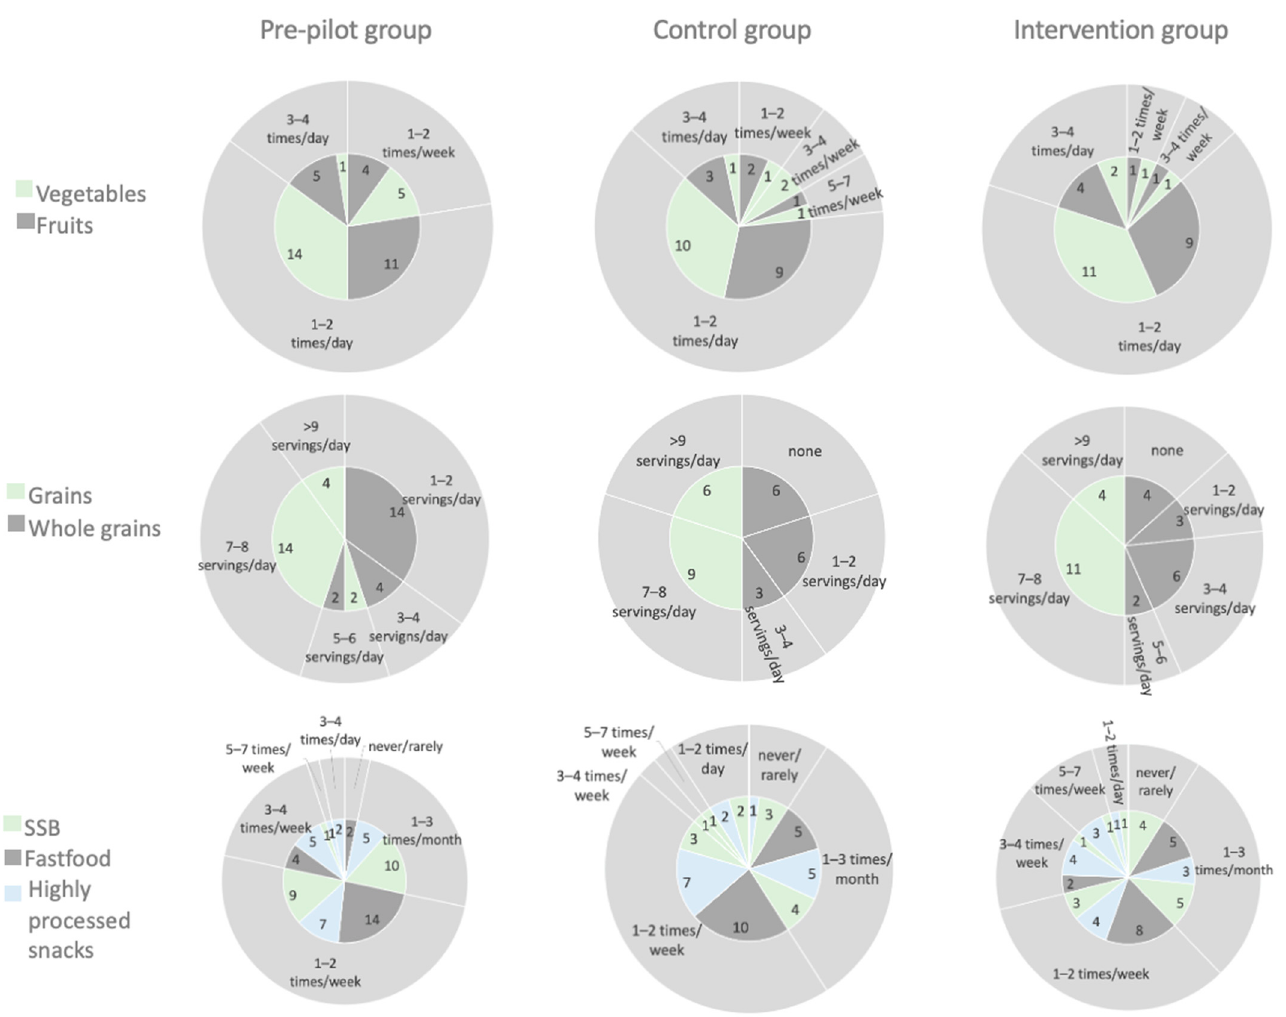
Figure 2. Baseline dietary habits. The actual numbers of participants in each category are depicted in the inner pie chart. the inner pie